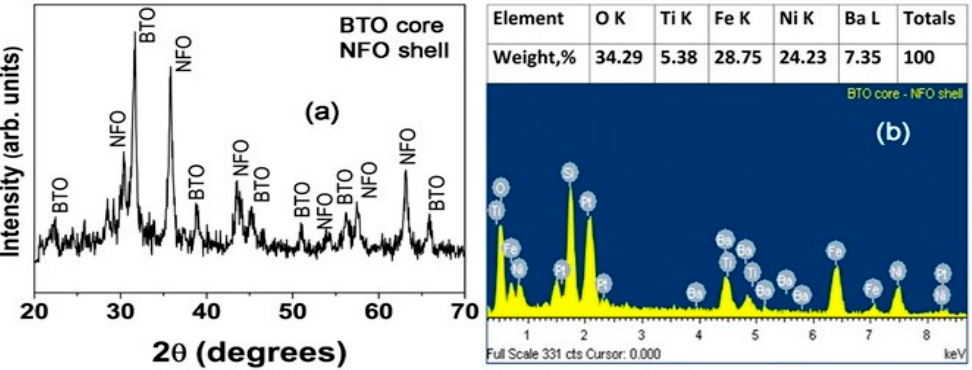
Figure 2. X-ray diffraction data ( a ) showing the absence of impurity phases and energy dispersive x-ray diffraction data ( b ) for chemical composition analysis for annealed fibers of BTO core and NFO shell (sample A).